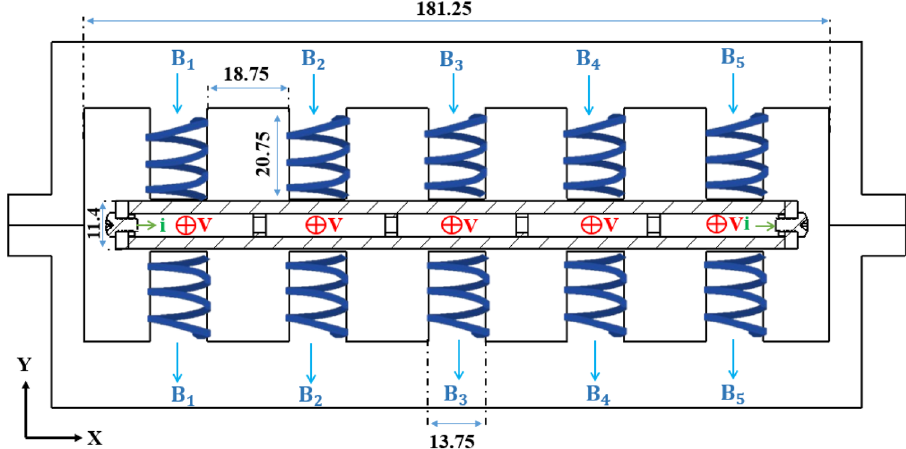
Fig. 2 The schematic and dimension (in mm) of the core and the channel of a magnetic arrayed